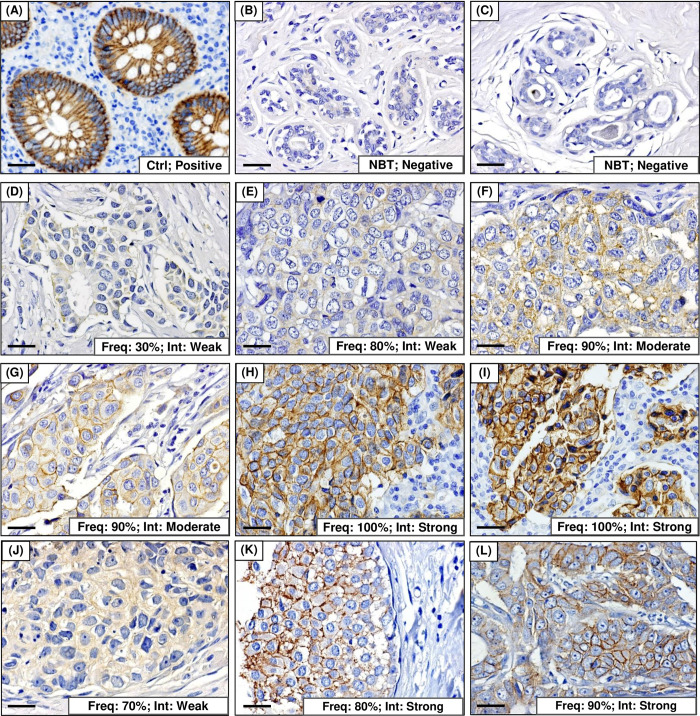
IHC of TRPM4 in normal breast tissues and breast cancer cases.(A) TRPM4 expression in appendix as control tissue (Ctrl) for IHC. (B-C) TRPM4 expression in two representative cases of normal breast tissues adjacent to tumor (NBT). (D-I) Representative breast cancer cases with various TRPM4 frequency and intensity. (J) TRPM4 expression in a representative fibroadenoma case. (K-L) Representative DCIS cases with 80–90% frequency and strong intensity. Freq: Frequency; Int: Intensity. All pictures were captured at 400x magnification. Scale bar for all images: 25 μm.